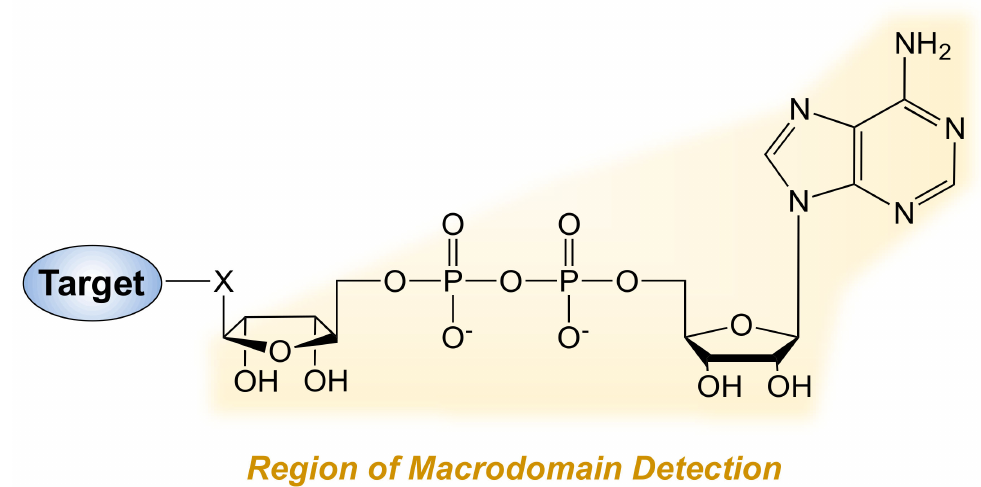
Figure 3. Detection of ADP-ribose (ADPR) by macrodomains. The chemical structure of a MARylated residue with the region of ADPR that is detected by PARP-14 (and other) macrodomains highlighted. Other ADPR binding motifs/domains (e.g., WWE motifs and PBZ domains) recognize distinct regions of the ADPR. Macrodomains 2 and 3 in PARP-14 likely contact the MARylated amino acid residue or other amino acids in the substrate protein, explaining why the PARP-14 macrodomains do not efficiently bind the terminal (protein distal) ADPR moieties in PAR chains